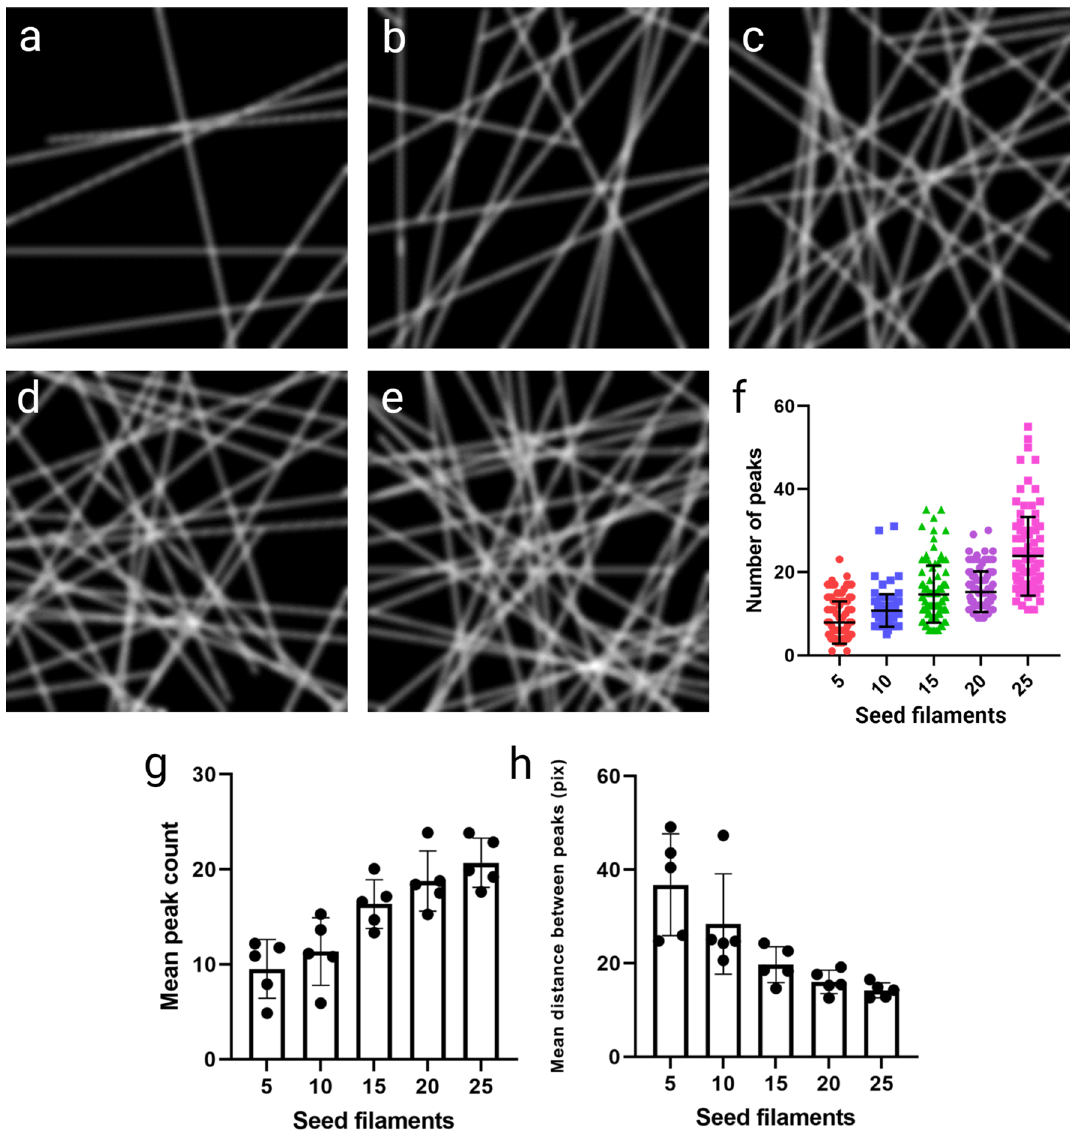
Figure 6. Simulation of meshworks to test density analysis. Simulated meshworks with ( a ) 5, ( b ) 10, ( c ) 15, ( d ) 20, and ( e ) 25 seed filaments, with each filament having the potential to act as a seed to a daughter filament. ( f ) Graph of peaks identified over 100 repeats of density analysis for the images shown in ( a – e ). ( g ) Mean peak count and ( h ) mean distance between peaks over 5 individual images for each seed filament